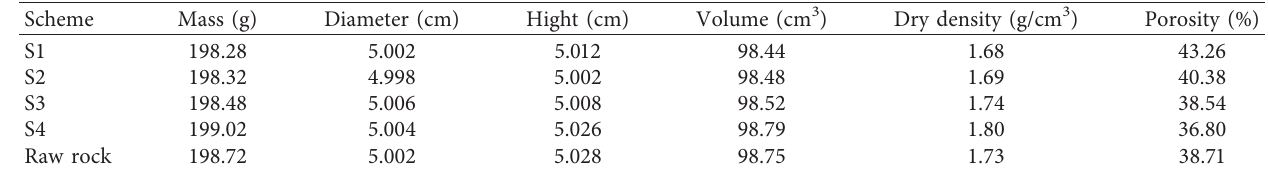
Table 18: Basic physical parameters of similar material samples and raw rock samples.